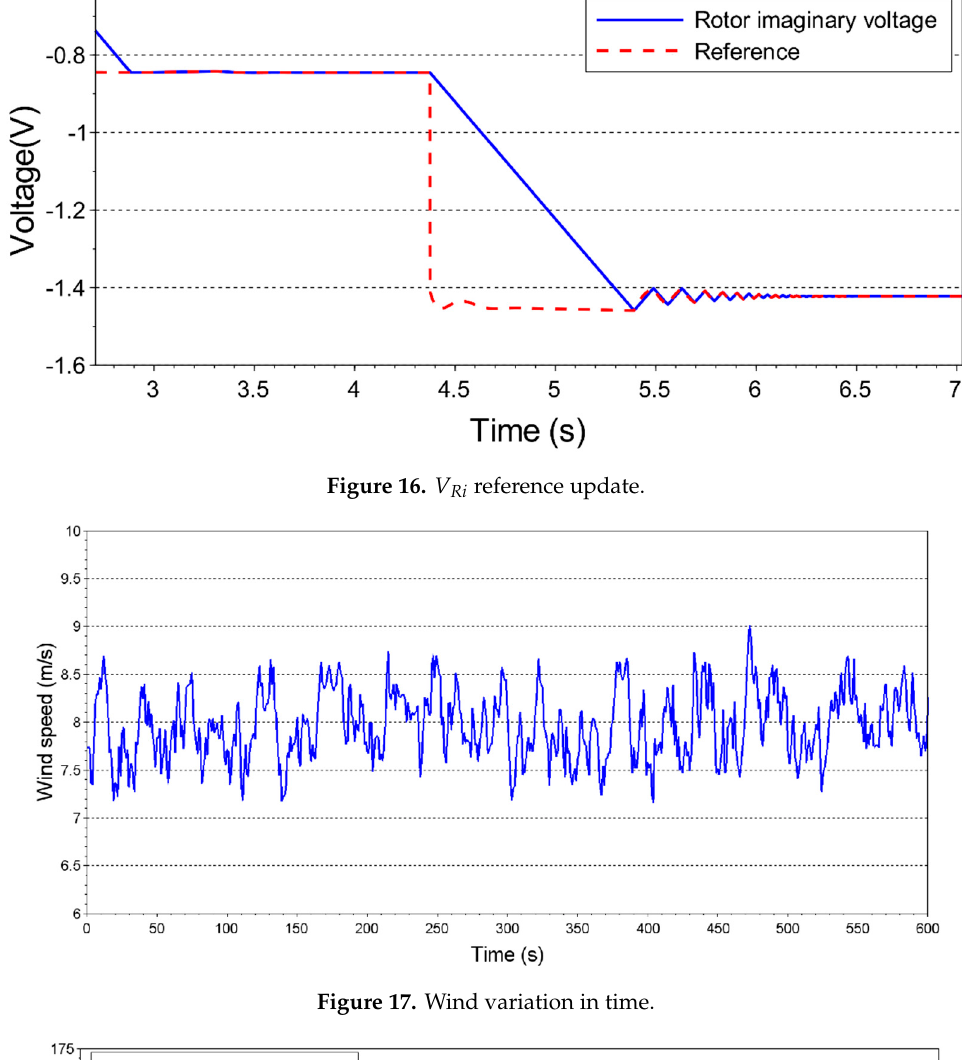
Figure 17. Wind variation in time.